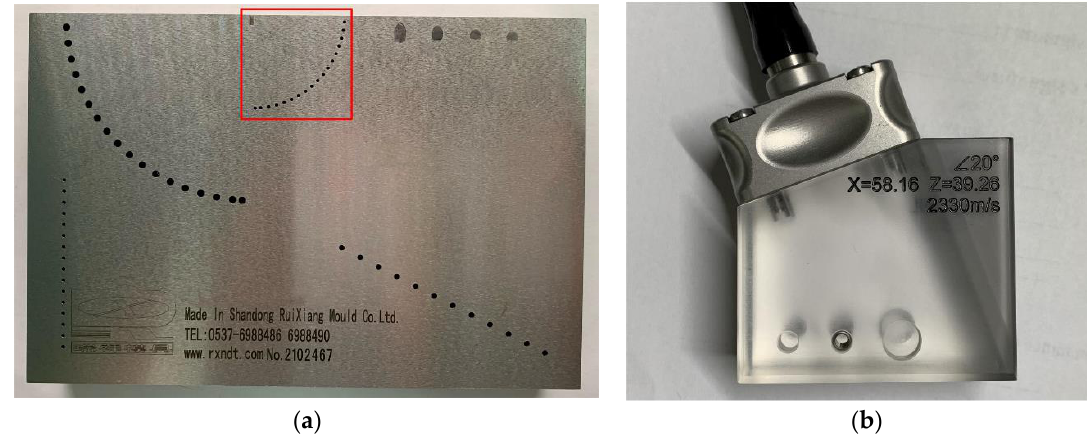
Figure 11. The standard B-type specimen and wedge used in experiment C. ( a ) The standard B-type specimen for phased